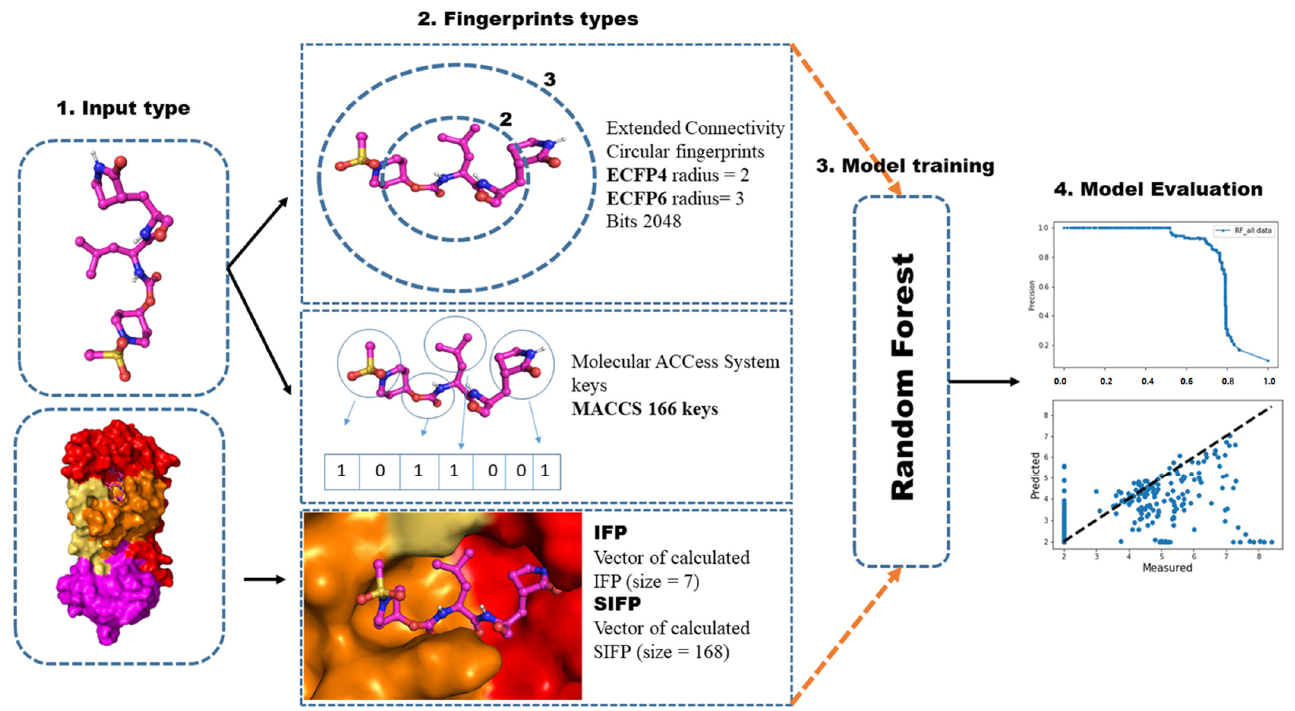
Figure 2. Workflow of 3CL pro -specific machine learning scoring function. The input was docked poses of proteins and ligands in the pdb and mol2 format.